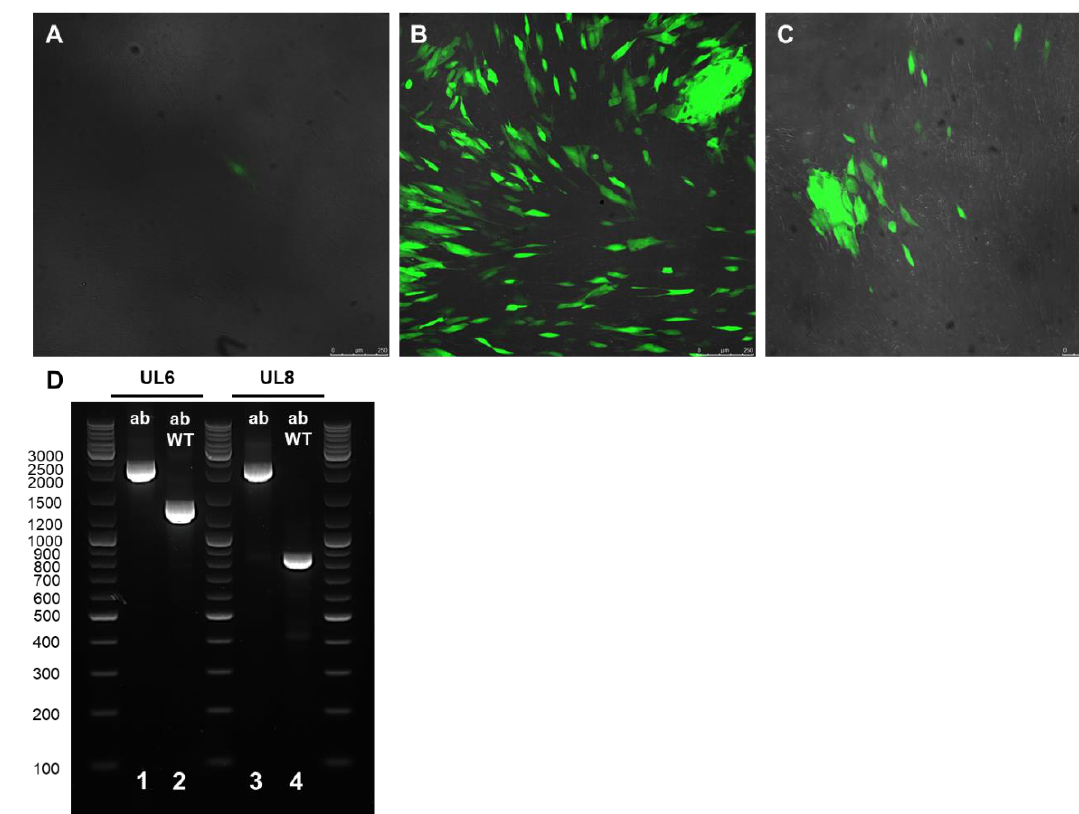
Figure 2. Representative images of MRC-5 cells infected with WT HCMV-BAC ( A ), Δ UL6-HCMV-BAC ( B ) and Δ UL8- HCMV-BAC ( C ) 14 days post-infection. Infected cells express GFP protein due to the integration of the gene in the BAC genome. ( D ) PCR products obtained to confirm the indicated Δ UL6 and Δ UL8 gene deletion of the reconstituted virus after the transfection in MRC-5 cells. PCR products were separated by electrophoresis in a 1.5% Agarose gel. Lane 1: amplification using the primers upstream and dowstream (ab) of the target gene using the indicated deletion mutant BAC DNA as a template. Lane 2: amplification using the primers upstream and dowstream (ab) of the target gene using the wild-type BAC DNA (WT) as a template. One kb DNA molecular weight marker was used as a ladder.